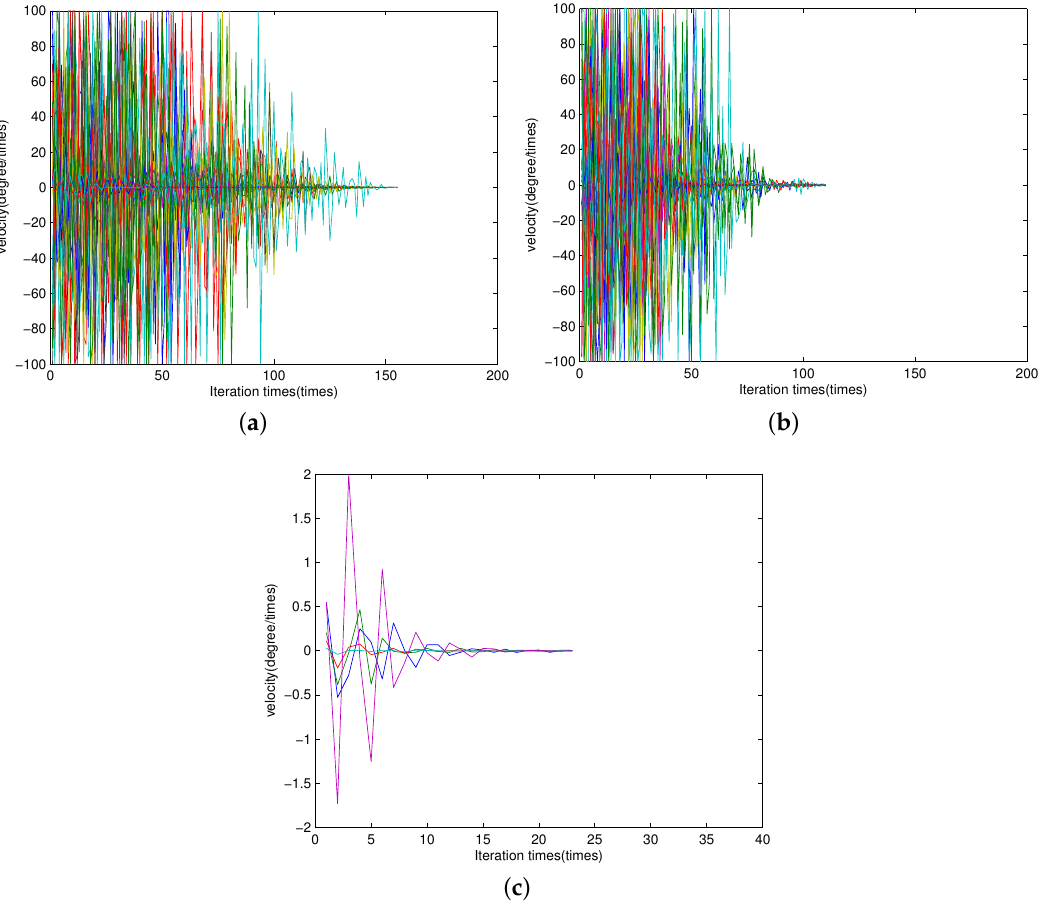
Figure 2. Iteration times of conventional PSO and Joint-PSO algorithms. ( a ) Iteration times of conventional PSO, m = 25, w = 0.4); ( b ) Iteration times of conventional PSO, m = 25, w is set according to Equation (26); ( c ) Iteration times of the proposed Joint-PSO, m = 5, w =